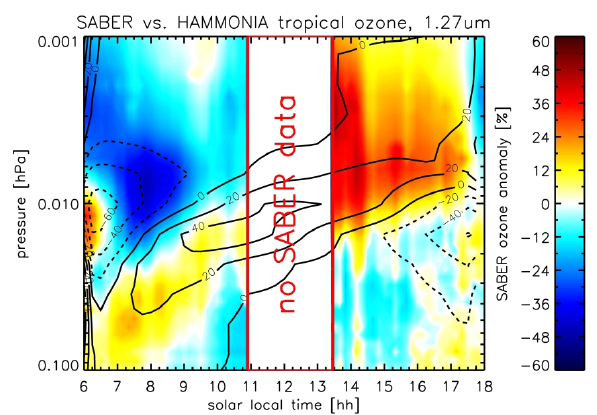
Fig. 4. SABER (retrieved at 9.6µm, color coding) and HAMMO- NIA (contour lines) daytime ozone variations (deviation from the daytime mean in %) between 0.1 and 0.001hPa.